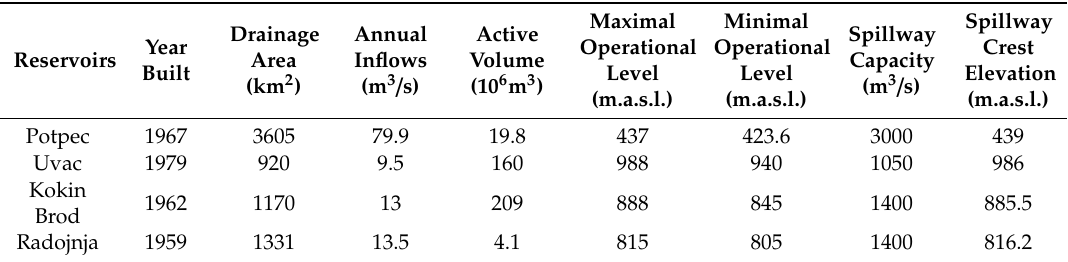
Table 1. The characteristics of reservoirs in the Lim water